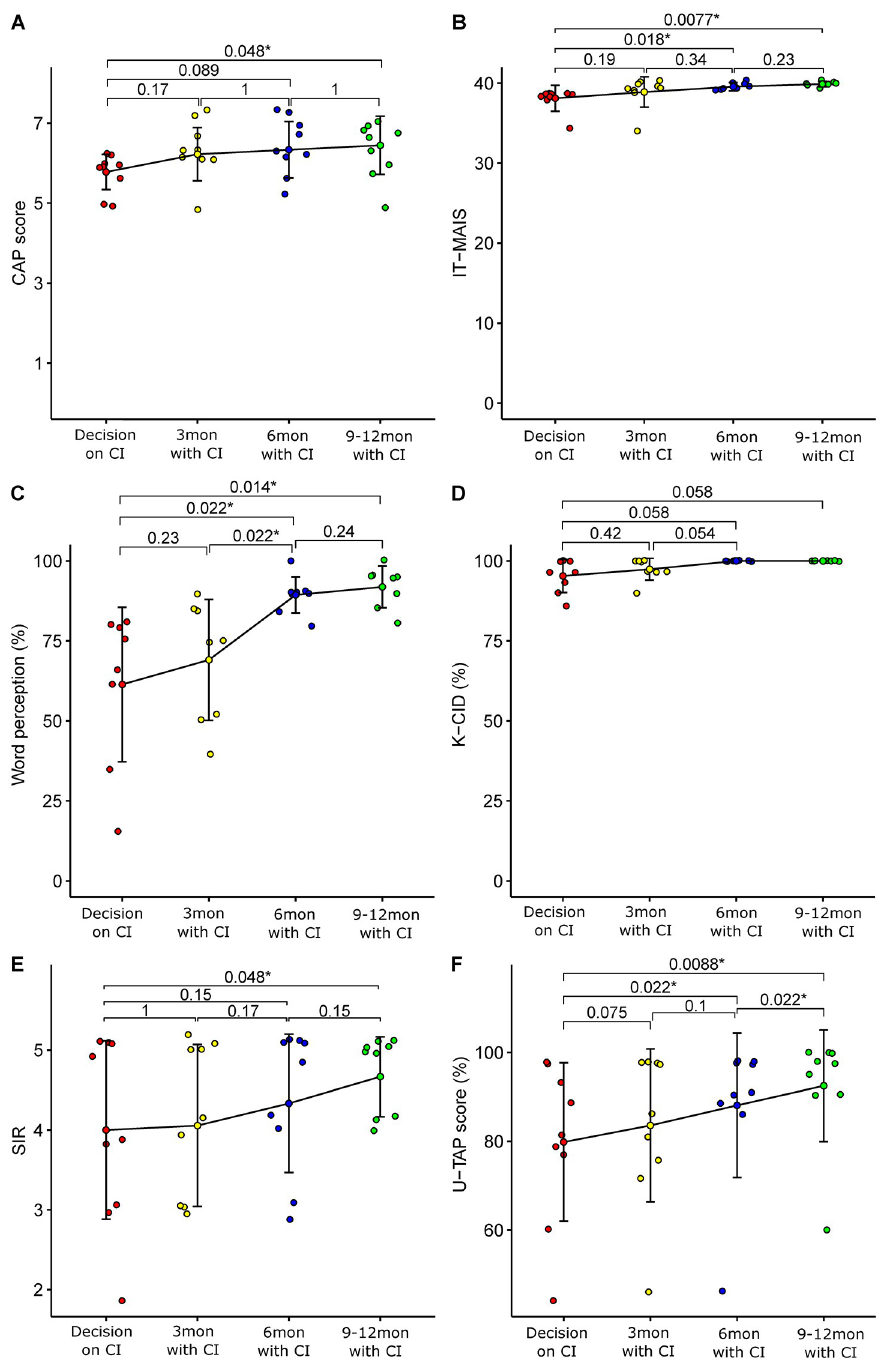
Fig 2. Comparisons of speech evaluation results between preoperative and post-implantation in child cochlear implantees with borderline language development. A, CAP. B, IT-MAIS. C, SIR. D, Spondee word perception. E, sentence perception in K-CID. F, U-TAP. The p-values are notated above the comparison lines (Wilcoxon signed rank test). CI, cochlear implant; CAP, Categories of Auditory Performance; IT-MAIS, Infant-Toddler Meaningful Auditory Integration Scale; SIR, Speech Intelligibility Rating; K-CID, Korean version of the Central Institute for the Deaf; U-TAP, Urimal Test of articulation and Phonation.